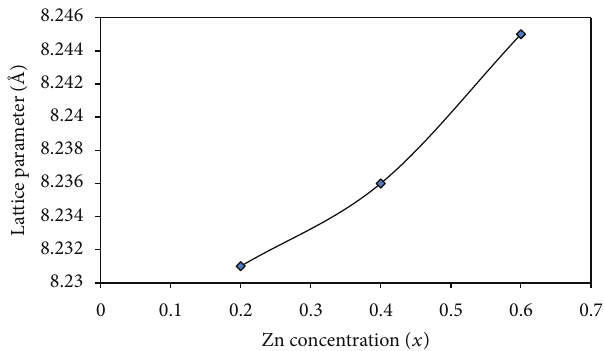
Figure 3: Variation of lattice parameter with Zn in NCZF.